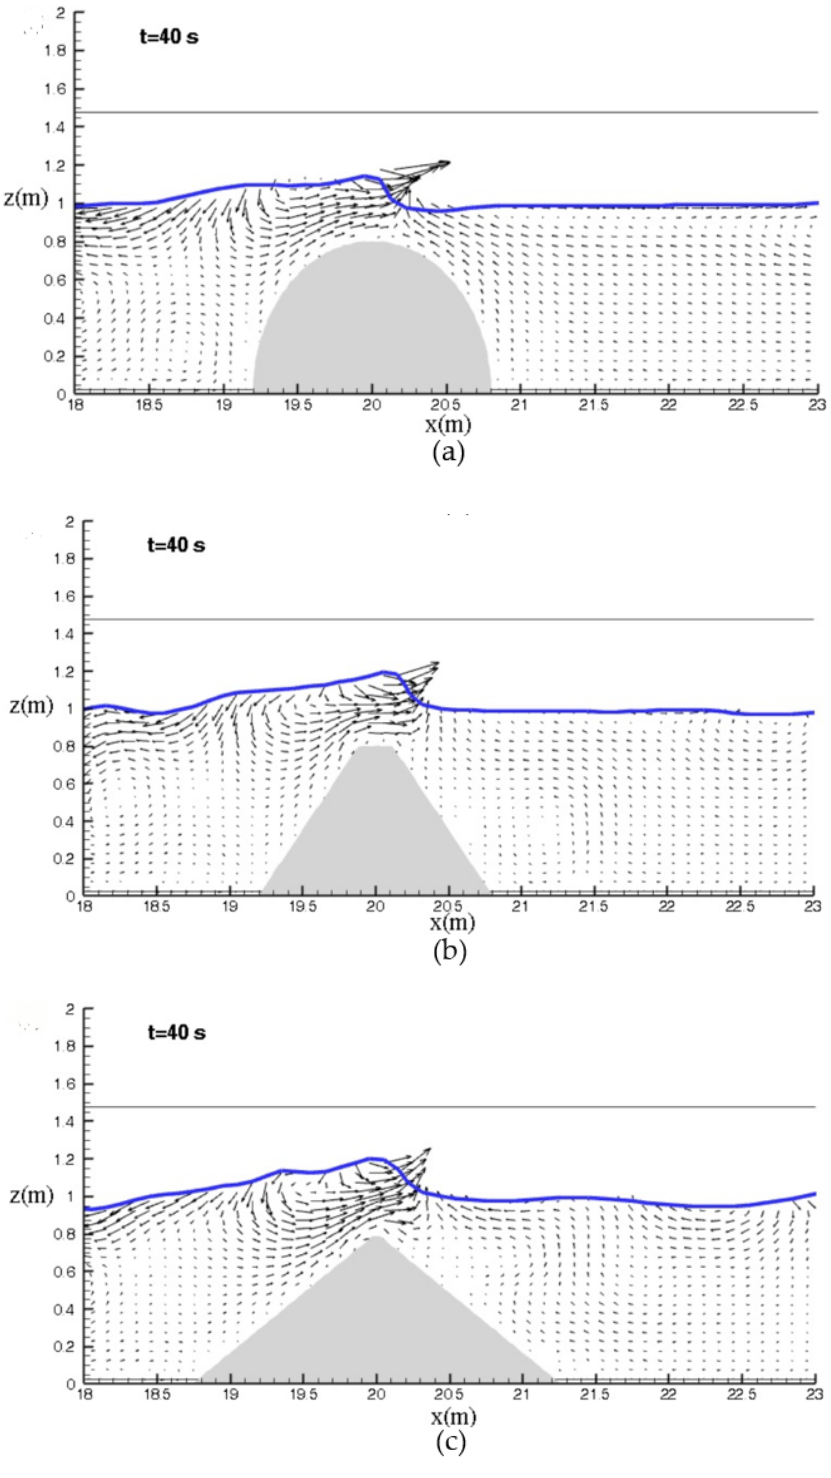
Figure 14. Instantaneously velocity fields at t = 40 s for the monochromatic wave with H i = 0.2 m and T = 3 s passing over three types of the submerged structures of ( a ) semicircle, ( b ) trapezoid, ( c ) triangle.